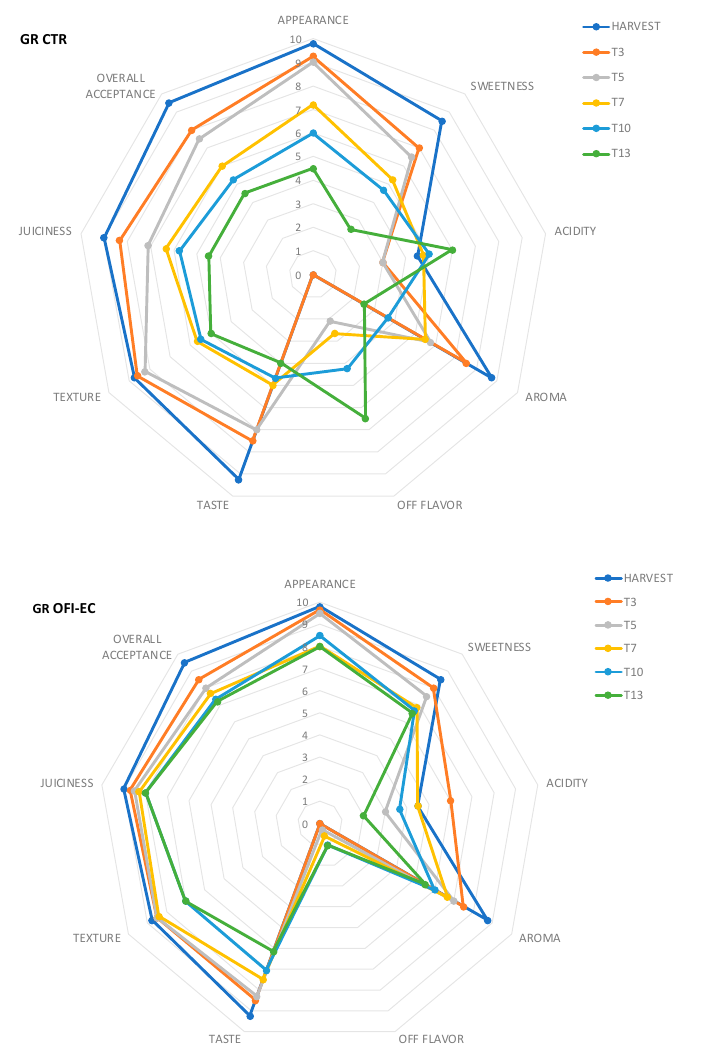
Figure 7. Sensorial analysis of minimally processed Gigante Rossa loquat fruit, untreated fruit (GR CTR), and fruits treated with mucilage (GR OFI-EC) after 3 (T3), 5 (T5), 7 (T7), 10 (T10), and 13 (T13) days of cold storage at 5 °C. Data are the mean ± SE ( n = 5 ).